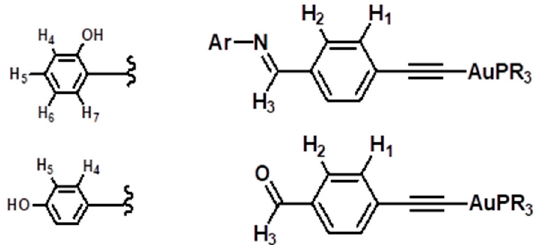
Figure 2. Numbering Scheme for NMR Spectral Assignment.